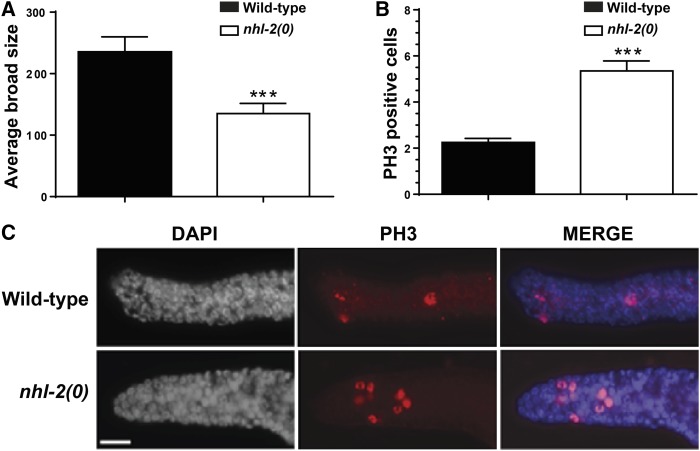
Brood size and elevated germ cell proliferation in nhl-2(0) mutants. (A) nhl-2(0) mutants display significantly reduced brood size when compared to wild-type animals at 20°. *** P <0.001, error bars represent SEM. n = 10. (B) Quantification of mitotic cells positive for PH3. n = 20. *** P <0.001, error bars represent SEM. (C) Represented images of germlines stained with PH3. Bar, 10 µm. n = 20.